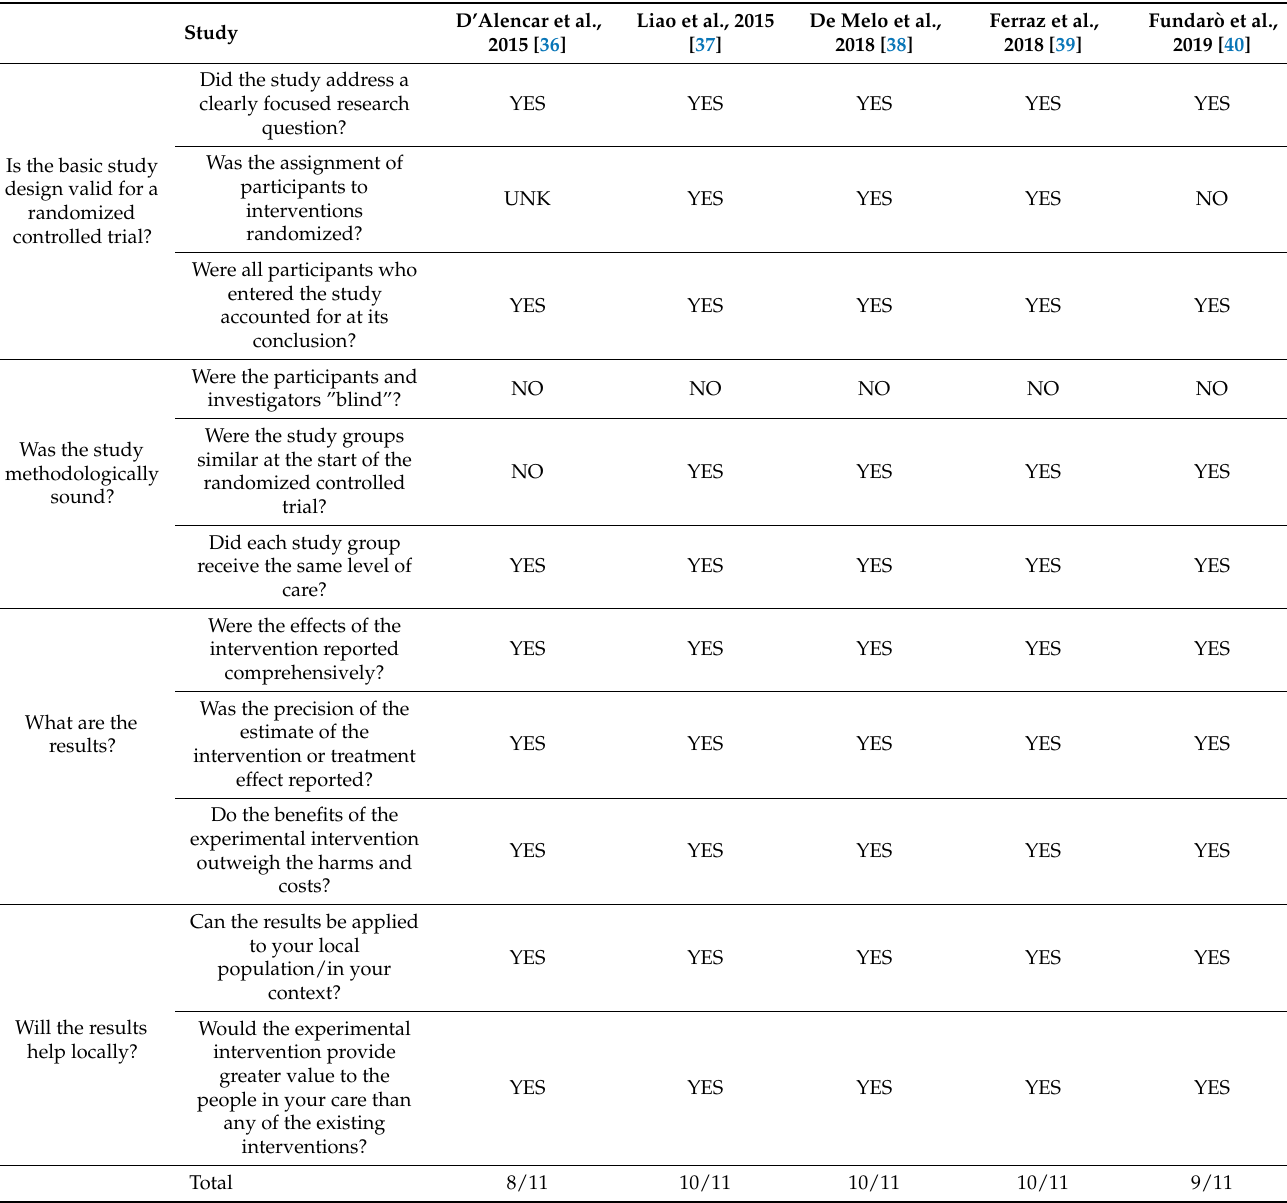
Table 2. Scores obtained after methodological evaluation according to the CASP Checklist